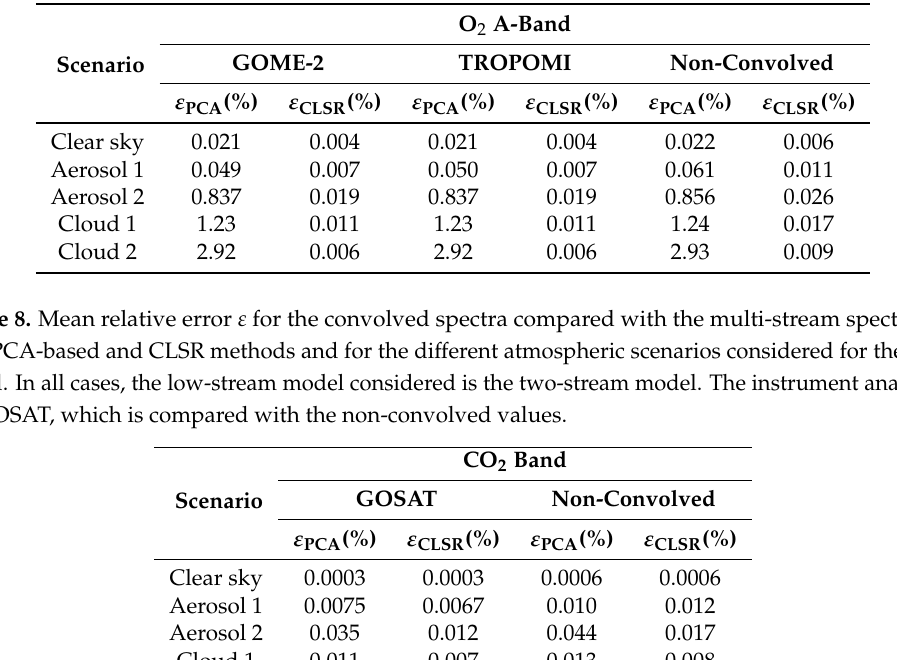
Table 7. Mean relative error ε for the convolved spectra compared with the multi-stream spectra for the PCA-based and CLSR methods and for the different atmospheric scenarios considered for the O 2 A-band. In all cases, the low-stream model considered is the two-stream model. The instruments analyzed are GOME-2 and TROPOMI, which are compared with the non-convolved values.